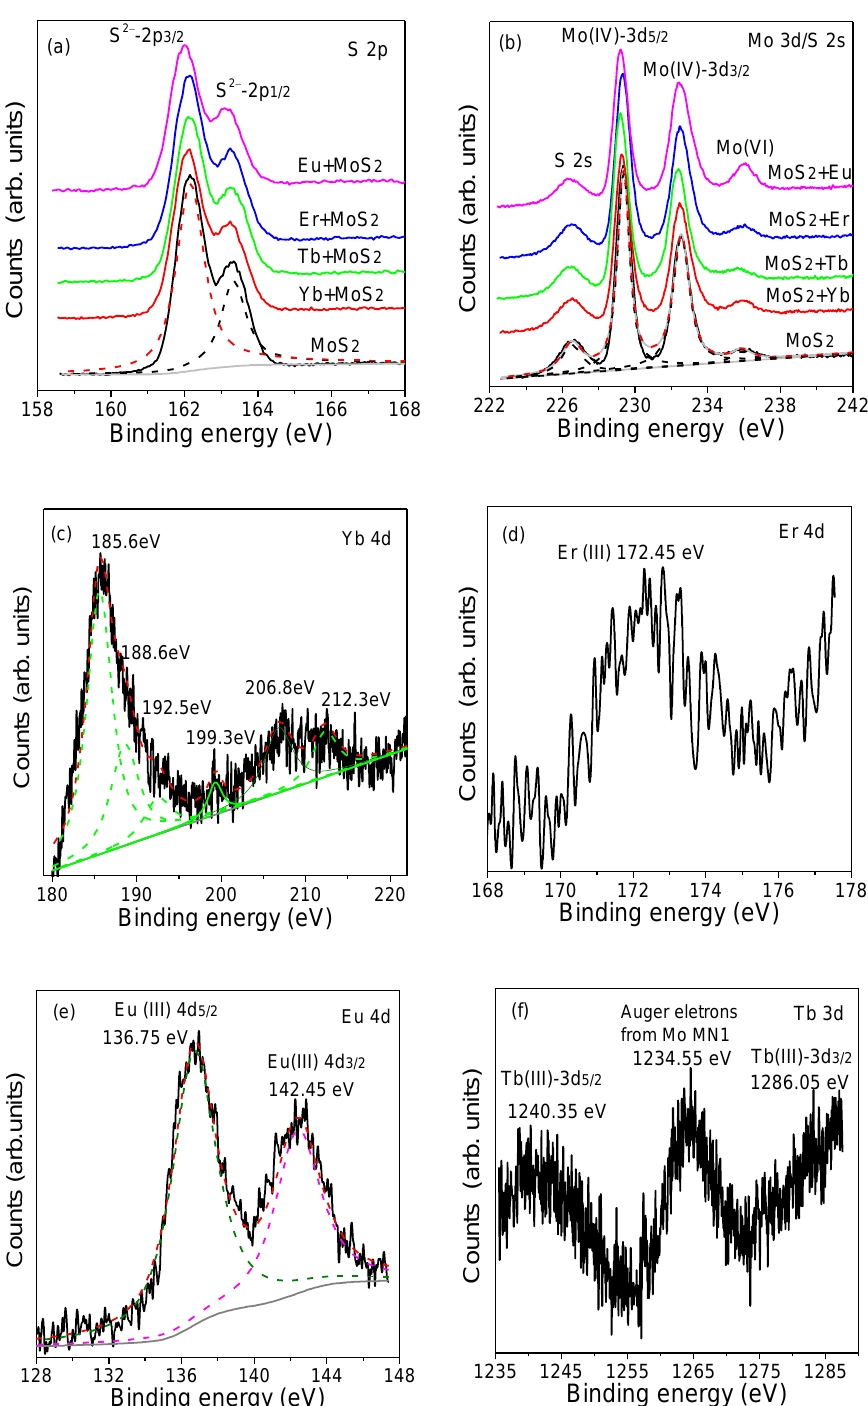
Figure 5. The XPS spectra and deconvolutions for the samples deposited on SiO 2 /Si substrate after annealing at 550 ◦ C in Ar + 10% H 2 . ( a ) S 2p ( b ) Mo 3d and S 2s, ( c ) Yb 4d for the Yb-doped MoS 2 , ( d ) Er 4d for the Er-doped MoS 2 , ( e ) Eu 4d for the Eu-doped MoS 2 and ( f ) Tb 3d for the Tb-doped MoS 2 sample.